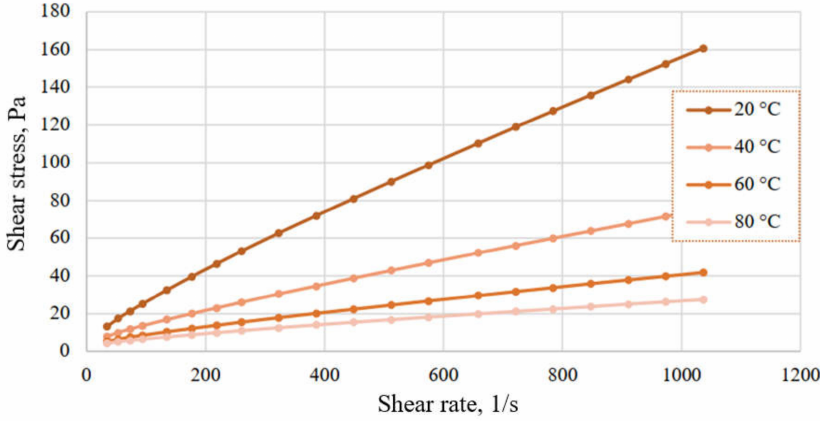
Figure 4. Dependence of shear stress on the shear rate for the hydrocarbon-based drilling mud at different temperatures.